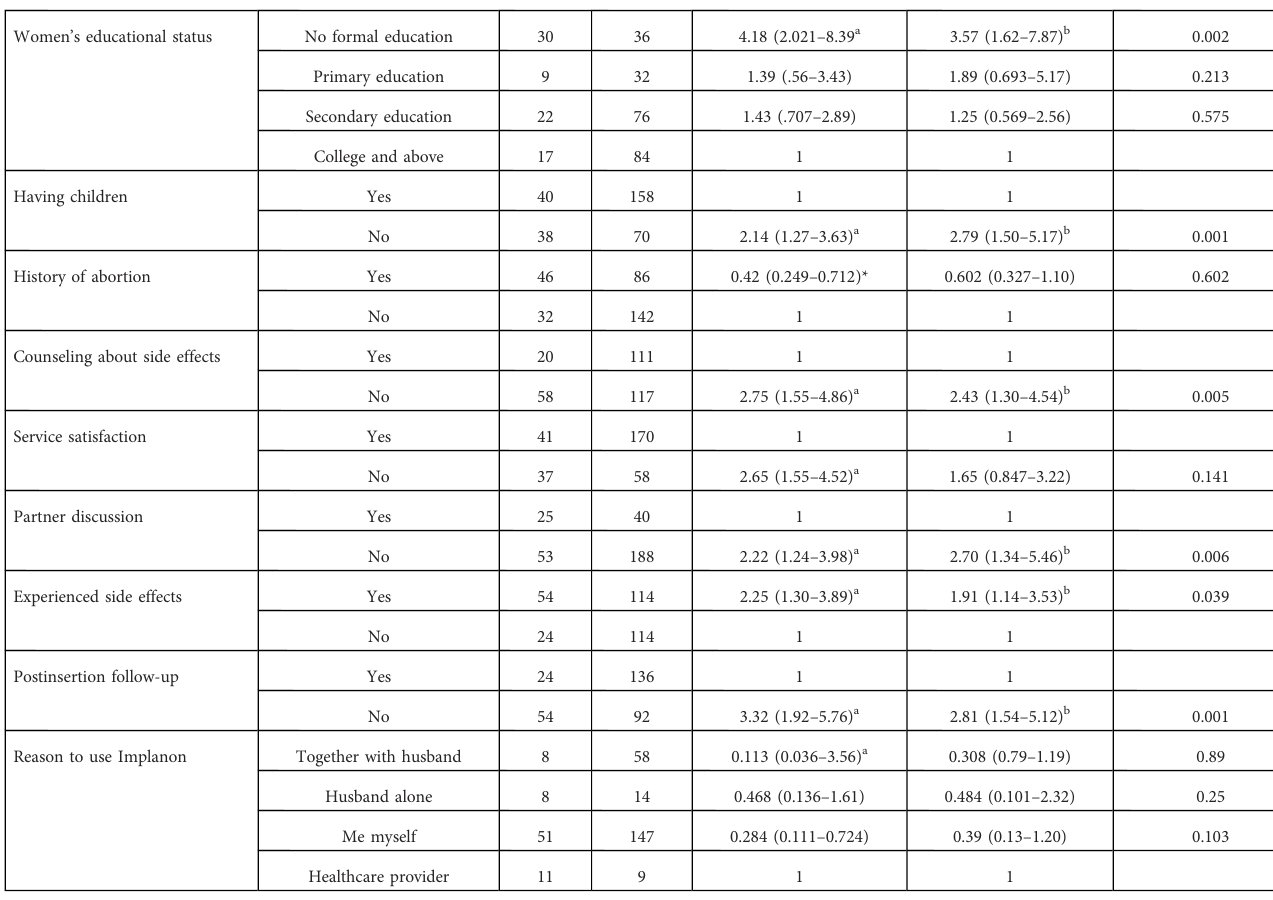
TABLE 4 Bivariable and multivariable binary logistic regression analyses results indicating the factors associated with the discontinuation of Implanon among women who used the device in Debre Berhan town, Northeast Ethiopia,